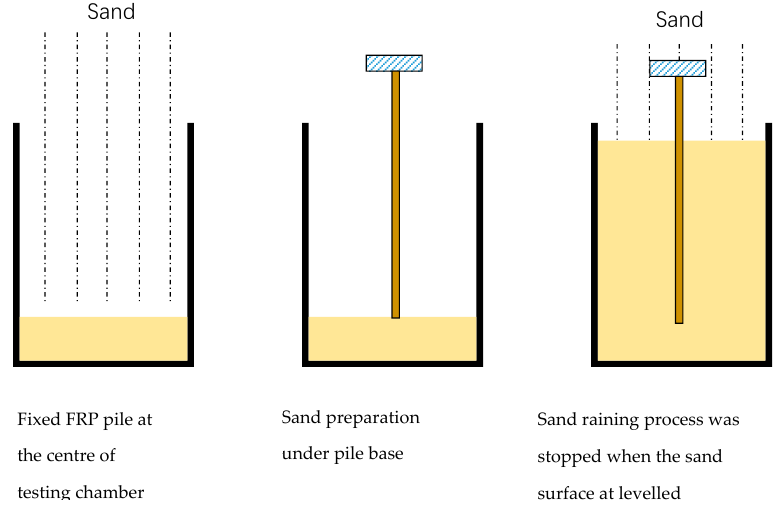
Figure 7. FRP preparation steps in the pressure chamber.